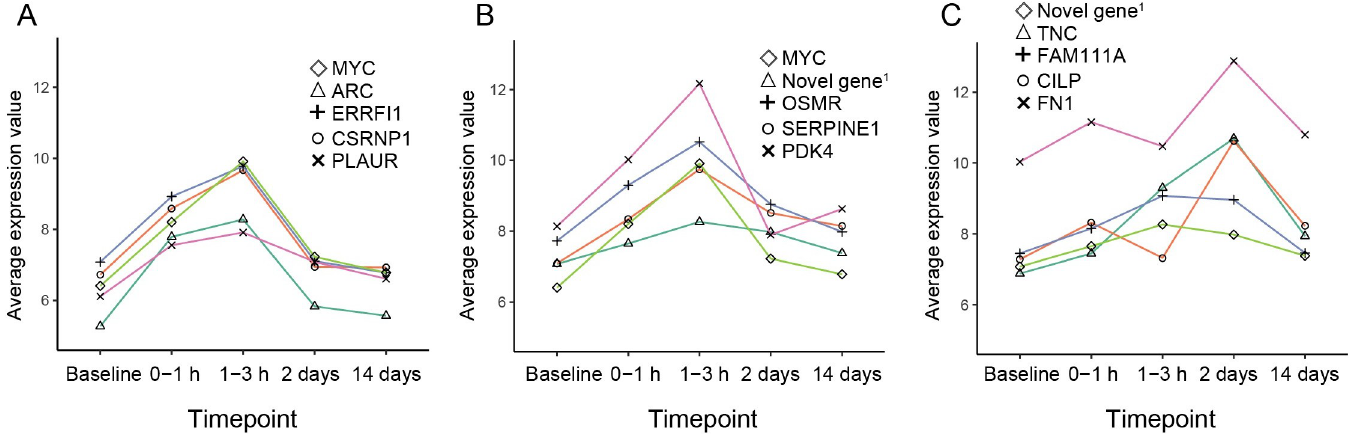
Fig 3. Longitudinal plots of average gene expression values (normalized and transformed counts) for top regulated genes from each timepoint compared to baseline. (A) Top genes (n = 5) for the 0–1 hours timepoint. (B) Top genes (n = 5) for the 1–3 hours timepoint. (C) Top genes (n = 5) for the two days timepoint. Novel gene 1 = ENSSSCG00000014997